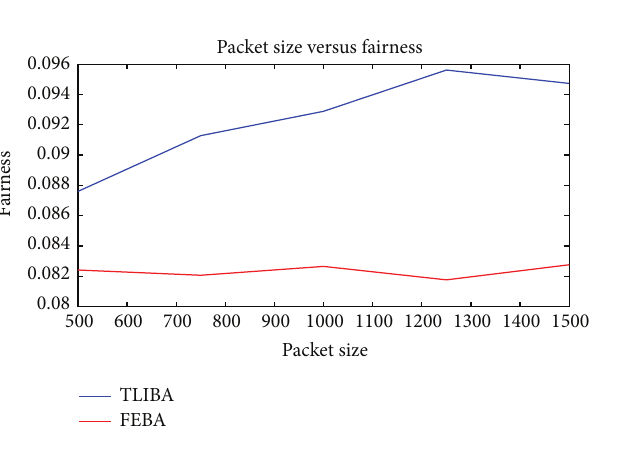
Figure 7: Packet size versus